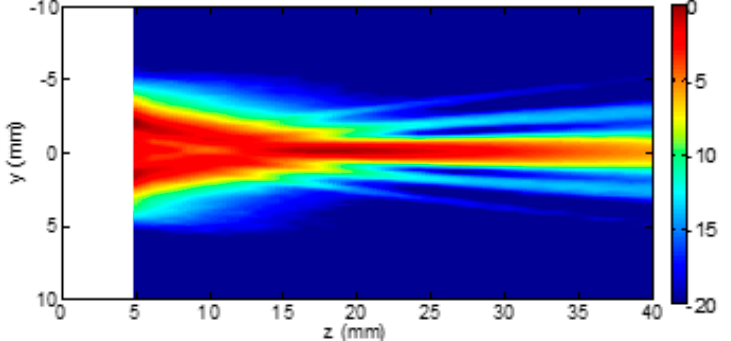
Figure 6. Elevation beam pro fi le of the Esaote LA533 linear array probe when pulses with a central frequency of 4 MHz are used. Figure courtesy of Esaote, Florence, Italy.